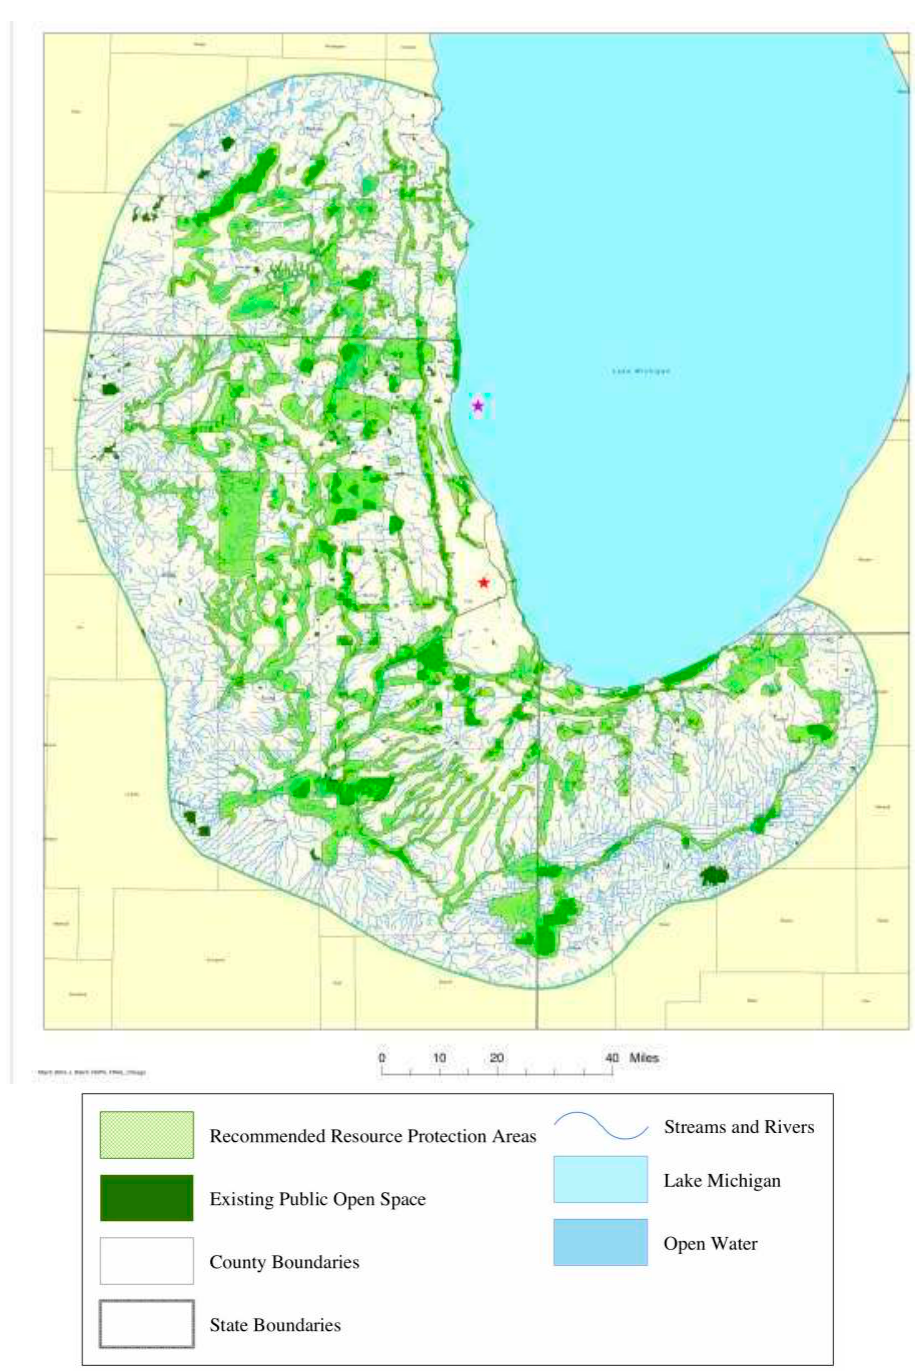
Figure 1. The Chicago Wilderness Green Infrastructure Vision (GIV): the GIV identifies 1.8 million acres of Recommended Resource Protection Areas associated with already protected public lands—spanning from southeast Wisconsin, through northeast Illinois into northwest Indiana and southwest Michigan. Green infrastructure is defined as the interconnected network of land and water that support biodiversity and provides habitat for diverse communities of native flora and fauna at the regional scale. It includes large complexes of remnant woodlands, savannas, prairies, wetlands, lakes, stream corridors, and the related natural communities that have been identified in the Biodiversity Recovery Plan. Green infrastructure may also include areas adjacent to and connecting these remnant natural communities that provide both buffers and opportunities for ecosystem